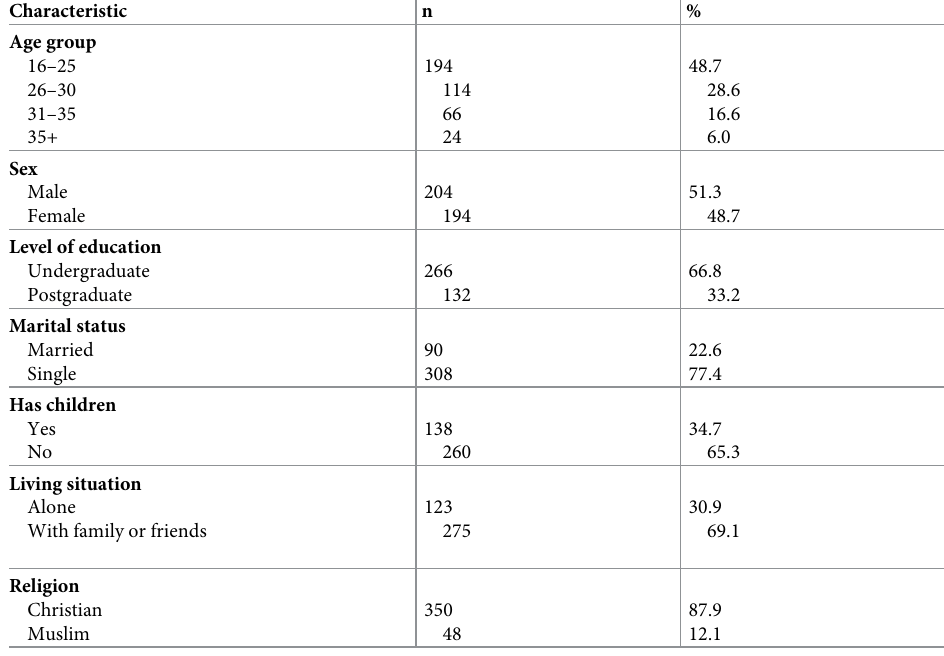
Table 1. Showing Sociodemographic characteristics of study